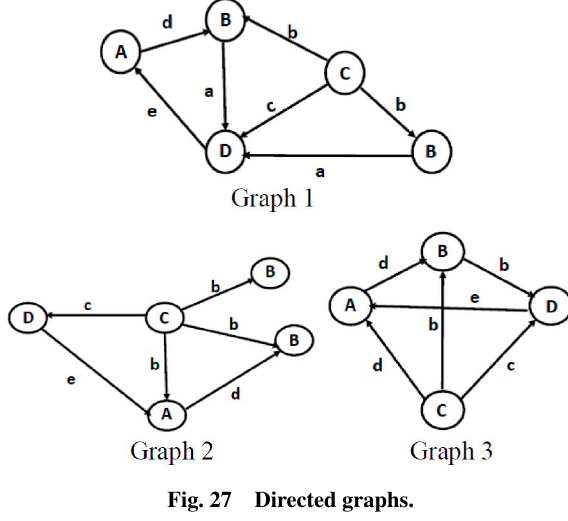
Fig. 27 Directed graphs.